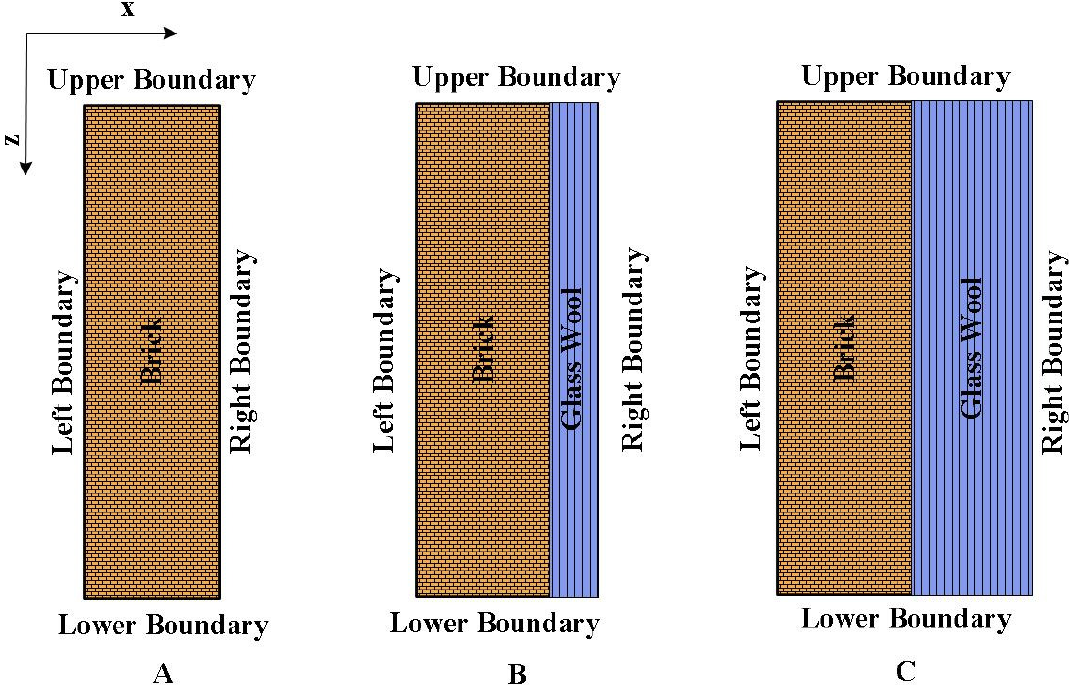
Figure 1. ( A ) One-layer wall, ( B ) and ( C ) wall with insulator.